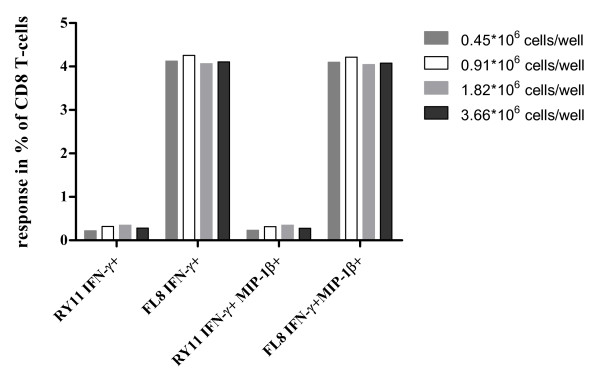
Variation in the number of cells/well in ICS assay. Different amounts of PBMC were stimulated with 2 different Nef derived optimal CD8 epitopes (FLKEKGGL, FL8 and RRQDILDLWIY, RY11). Analyzed responses are shown on the x axis.